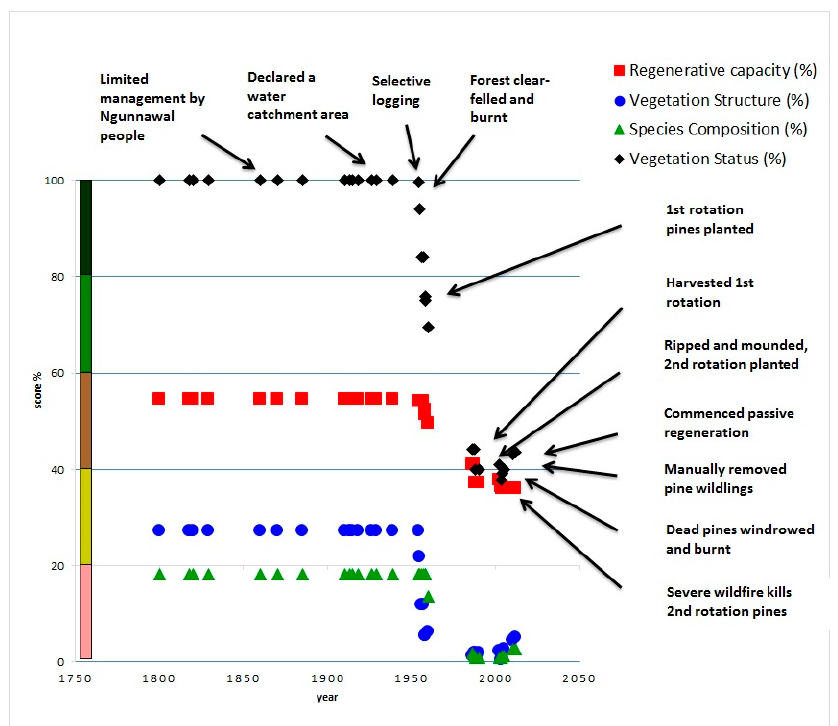
Figure 2. Case Study 1: Rocky Valley, Bogong High Plains, cold wet agro-climate region, Poa tussock grassland.